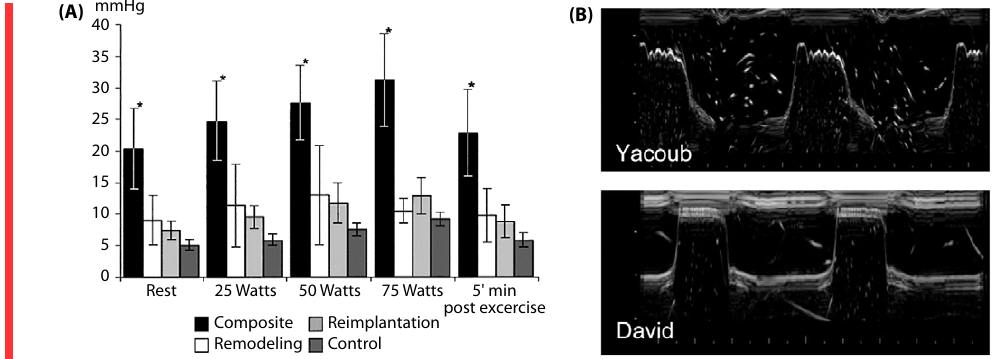
Figure. 7 Valve performance in terms of transvalvular pressure gradient (TPG) and valve dynamics. (A) A comparison of maximum TPG across the aortic valve during different levels of exercise (* significantly